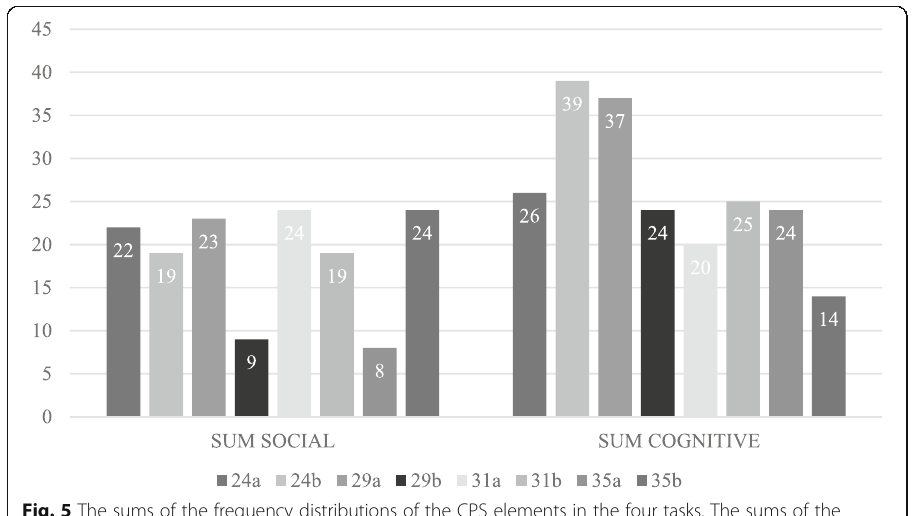
Fig. 5 The sums of the frequency distributions of the CPS elements in the four tasks. The sums of the frequency distributions of the CPS elements in all the four tasks are presented at the level of an individual participant. The participants are displayed by their student IDs, such as students 24a, 24b and so forth, starting from the left side of the chart. For example, for student 24a, the sum of ‘ Social ’ is 22 and the sum of ‘ Cognitive ’ is 26, whereas for student 24b, the sum of ‘ Social ’ is 19 and the sum of ‘ Cognitive ’ is